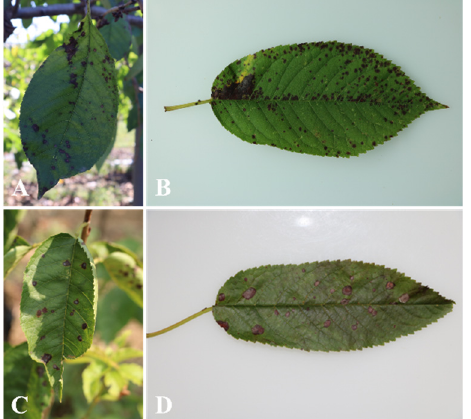
Figure 1. Symptoms of cherry leaf spot. ( A , B ) symptom type 1; ( C , D ) symptom type 2. Table 1. Information and GenBank accessions of Fusarium isolates obtained in this study.